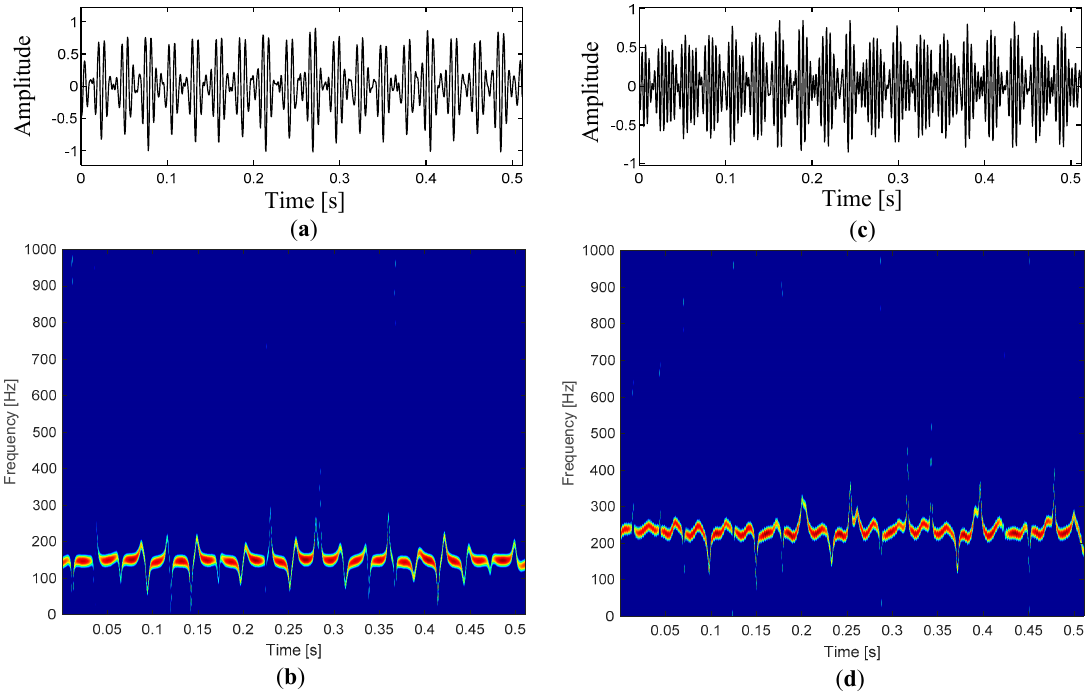
Figure 22. The time domain waveform of the displacement signal.